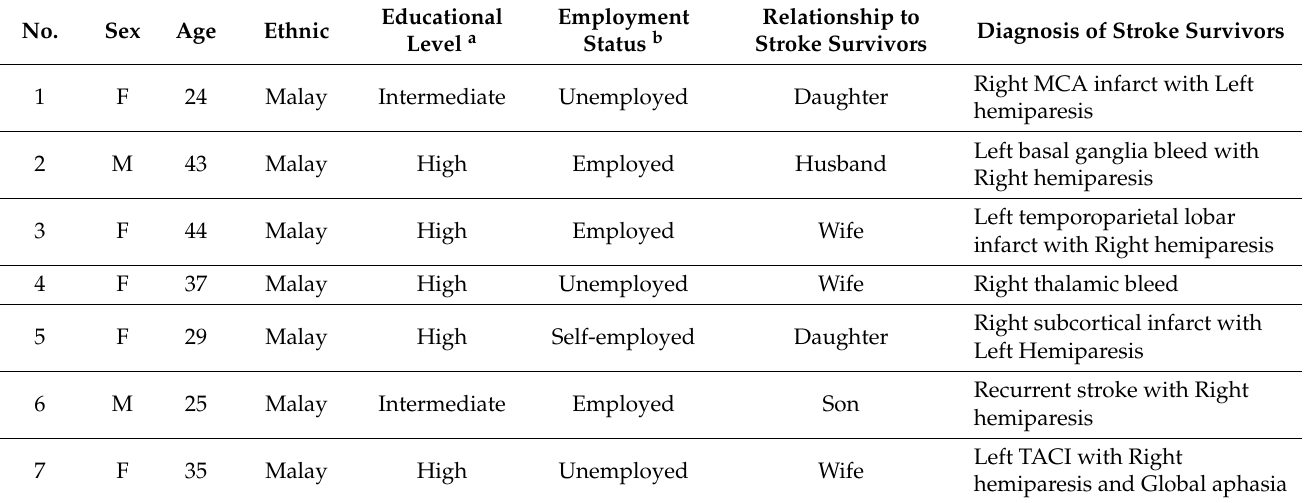
Table 1. Characteristics of family caregivers and stroke